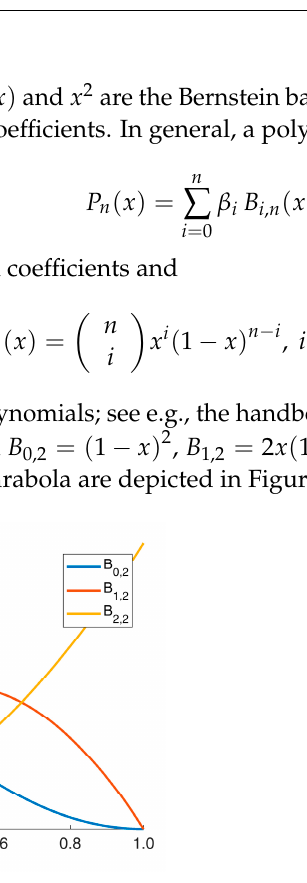
Figure 7. Bernstein basis polynomials for a parabola in the interval [0, 1].